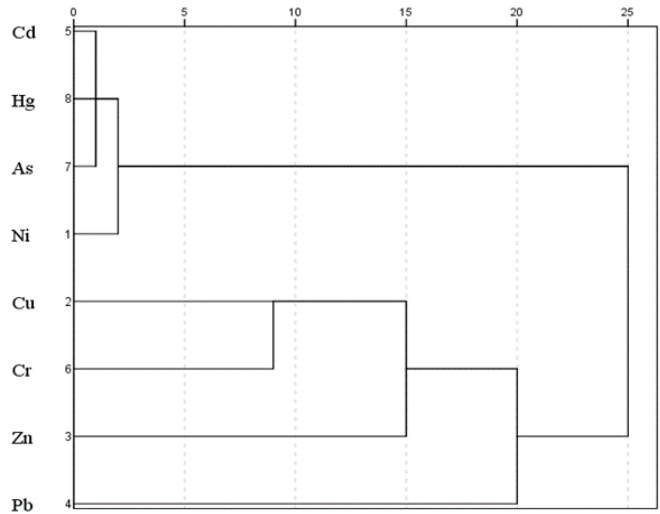
Figure 5. Heavy metal spectrum of sediments in the Three Gorges Reservoir.